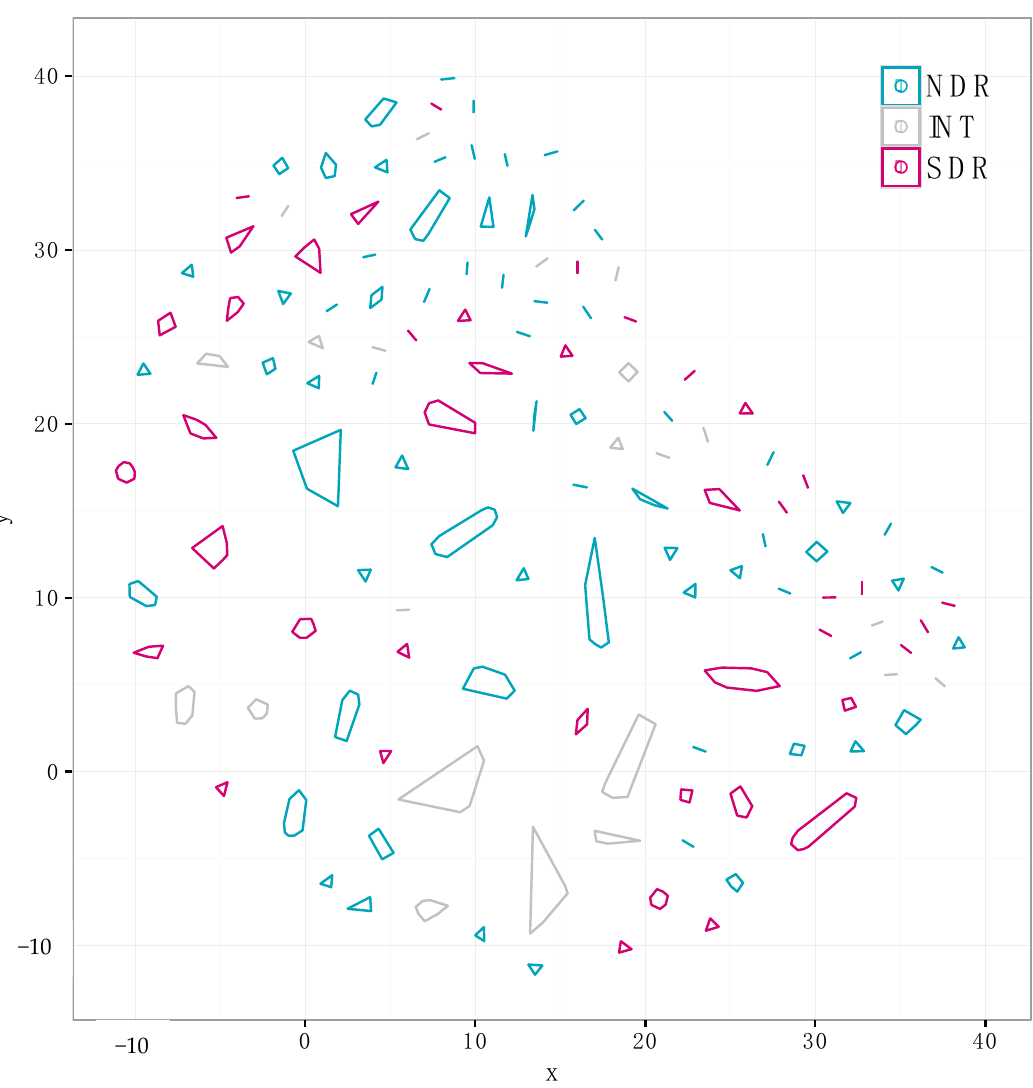
Figure 5. We identified 310 non-redundant distinct SMGCs using our annotation-independent gene clustering approach (see Materials and Methods). Each point represents a unique SMGC from a single genome, and colors correspond to clade affiliation. SMGCs with a similar gene composition are clustered spatially, and cluster membership is depicted with polygons. The same data is presented in a different network diagram in Figure S1.